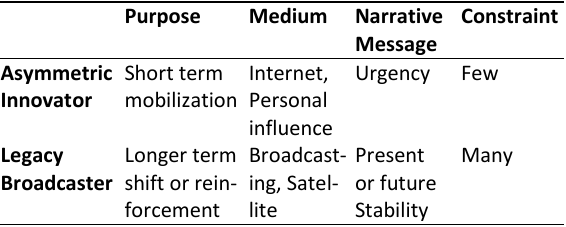
Table 1 . Distinction between asymmetric innovators and legacy